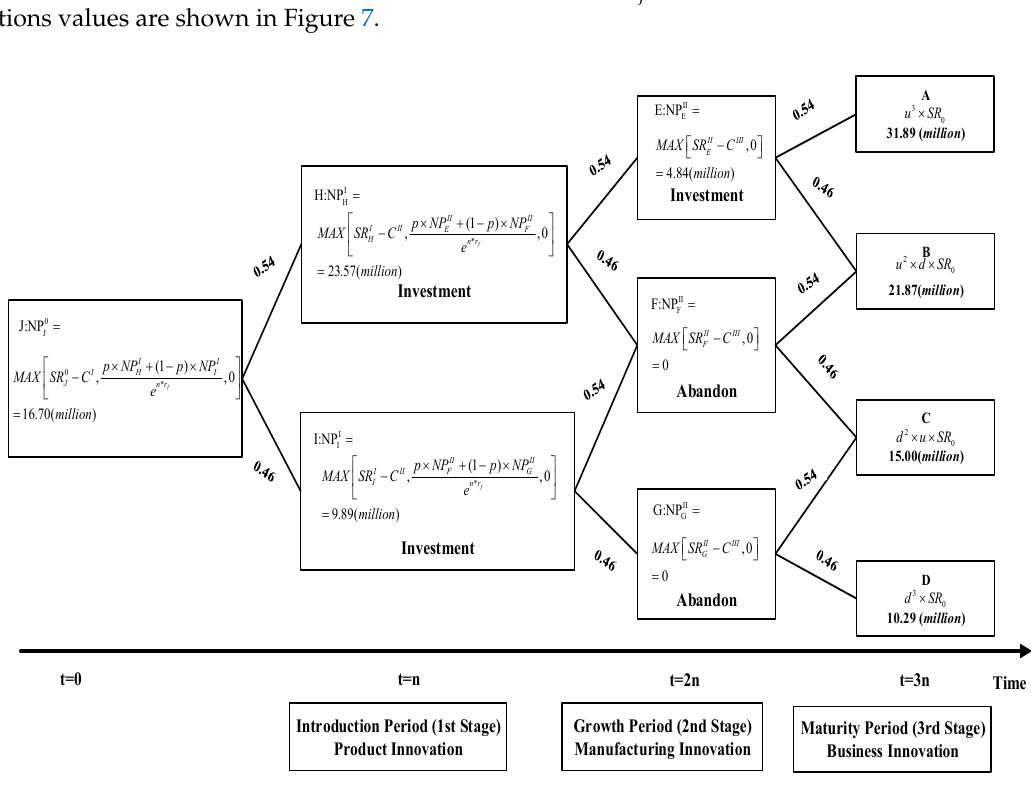
Table 2. The influence of the risk-adjusted discounted rate r on equity values.